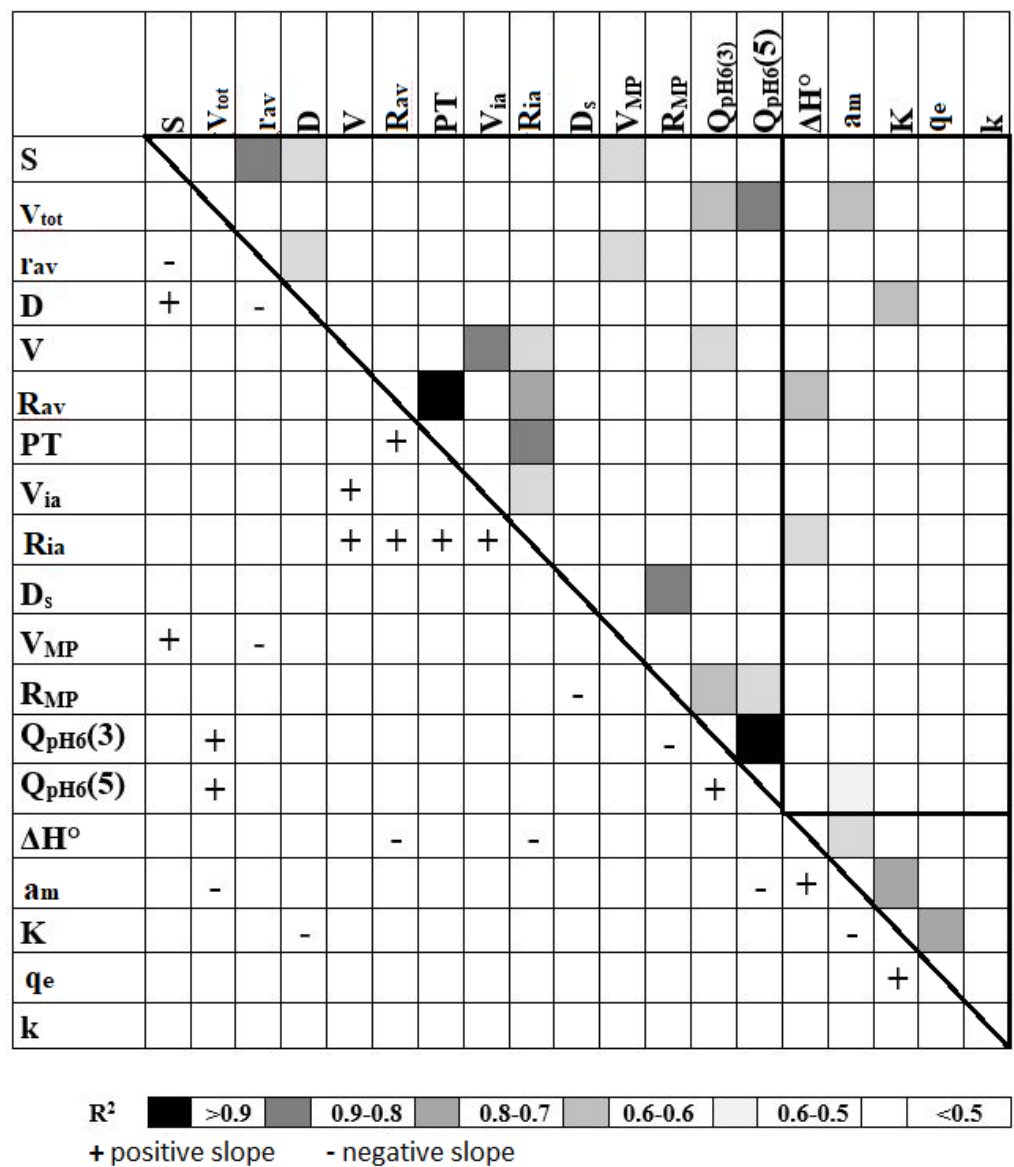
Figure 14. Ranges of correlation coe ffi cients and signs of the linear regressions between all studied parameters of all studied adsorbents. Both the above values can be read from an intersection of the column and the row of parameters of interest. The diagonal line is drawn for 1:1 dependencies between the same parameters. Abbreviations of the parameters are the same as in Tables